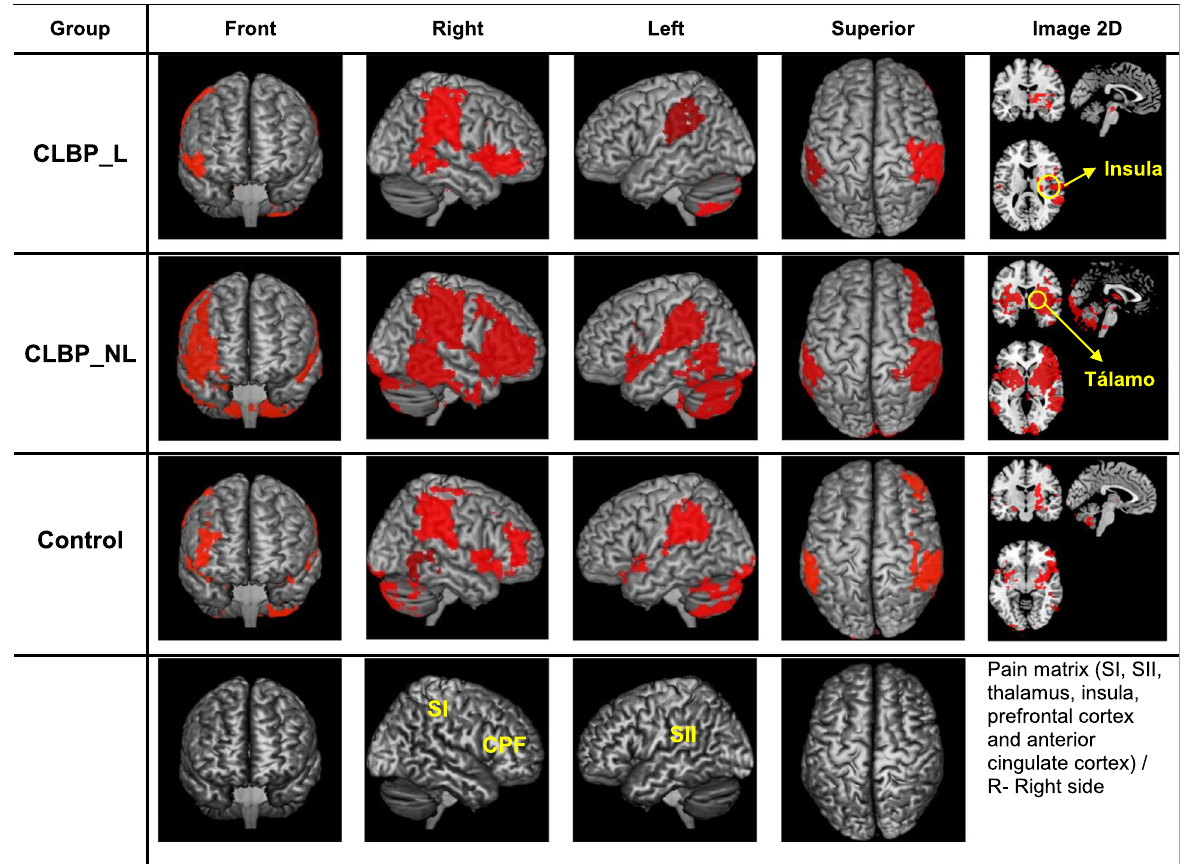
Fig. 1 Hemodynamic response, after painful stimulation, in the three groups studied, showed activation in the areas related to the pain